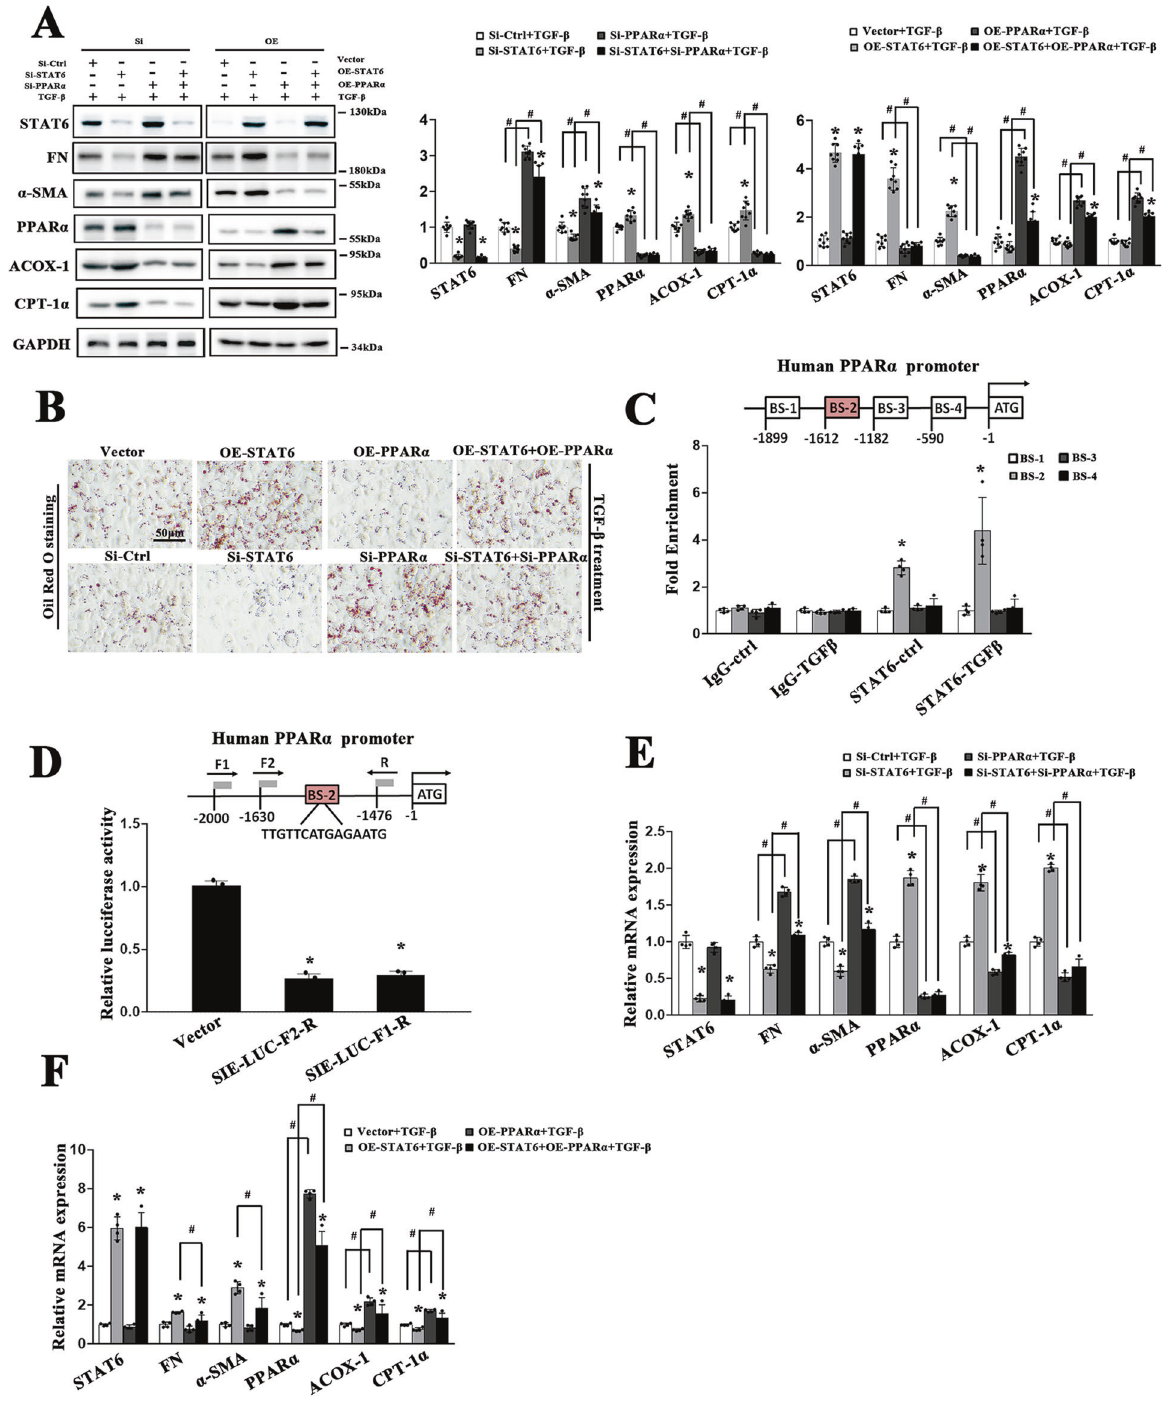
Fig. 5 STAT6 regulates FAO and fi brotic related protein expression by targeting PPAR α in tubular cells. HK2 cells were transfected with siRNA or plasmid for STAT6 or PPAR α . After 24 h incubation, cells were treated with TGF- β (5 ng/ml) for another 24 h. A Cell lysates were harvested and subjected to immunoblot analyses with the indicated antibodies. Quanti fi cation of relative protein expression was determined. Results are expressed as the mean ± SD ( n = 4 * p < 0.05, SiCtrl/Vector vs . siSTAT6/STAT6 transfection; # p < 0.05, SiCtrl/Vector vs . SiPPAR α /PPAR α transfection). B Representative micrographs showing the Oil Red O staining of indicated treatments in HK2 cells. C Identi fi cation of four SIEs in the promoter of PPAR α . The potential site of STAT6 binding to PPAR α promoter with detected by ChIP assay in HK2 cells with or without TGF- β (5 ng/ml) 24 h treatment. Results are expressed as the mean ± SD ( n = 4 * p < 0.05, IgG vs . STAT6 immunoprecipitation). D The different human PPAR α promoter constructs were cloned upstream of a luciferase reporter gene. HK2 cells were either transfected with empty vector or these constructs along with Renilla luciferase reporter for 24 h and followed by another 24 h TGF- β treatment, dual-luciferase activities were measured. The experiment was repeated three times, each with triplicate samples. Data are expressed as mean ± SD ( n = 3, * p < 0.05, Vector vs . PPAR α promoter constructs). E , F HK2 cells were transfected with indicated siRNA and plasmid for 24 h in serum-free medium, followed by TGF- β (5 ng/ml) 24 h and harvested for qRT-PCR analysis of the indicated genes. Results are expressed as the mean ± SD ( n = 4 * p < 0.05, SiCtrl/ Vector vs . siSTAT6/STAT6 transfection; # p < 0.05, SiCtrl/Vector vs . SiPPAR α /PPAR α transfection). Cell Death and Disease (2022)